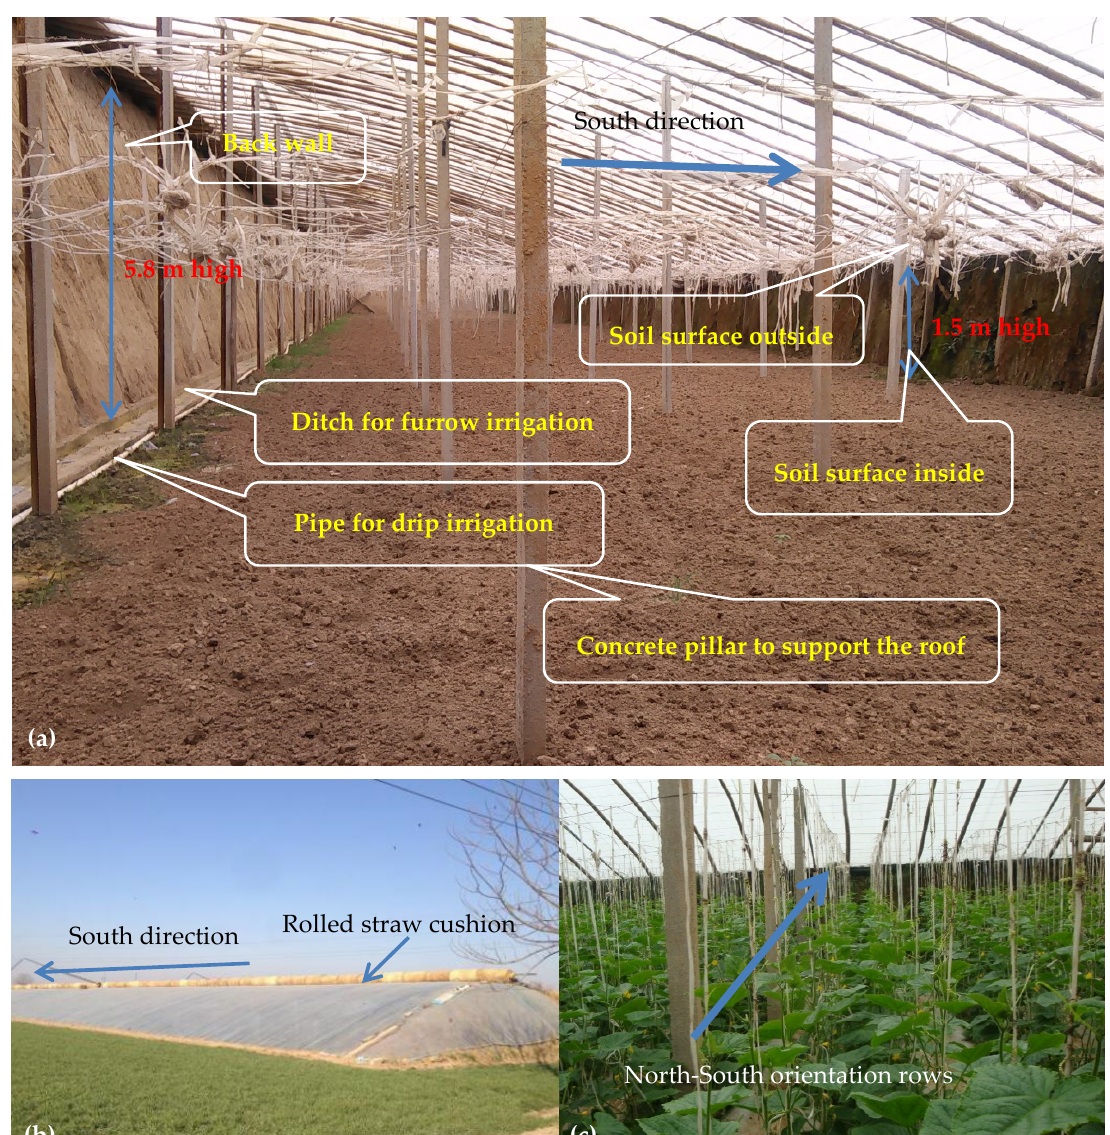
Figure 1. Photos of the sunken solar greenhouse. ( a ) Inside view of the sunken solar greenhouse pictured just after soil preparation (photo taken on 12 October 2014). ( b ) Outside view of the sunken solar greenhouse in winter. The front plastic cover is facing south, and the rolled straw cushion is seen on the top of the roof. ( c ) A view of the cucumber plants inside the sunken solar greenhouse (photo taken on 28 December 2014).